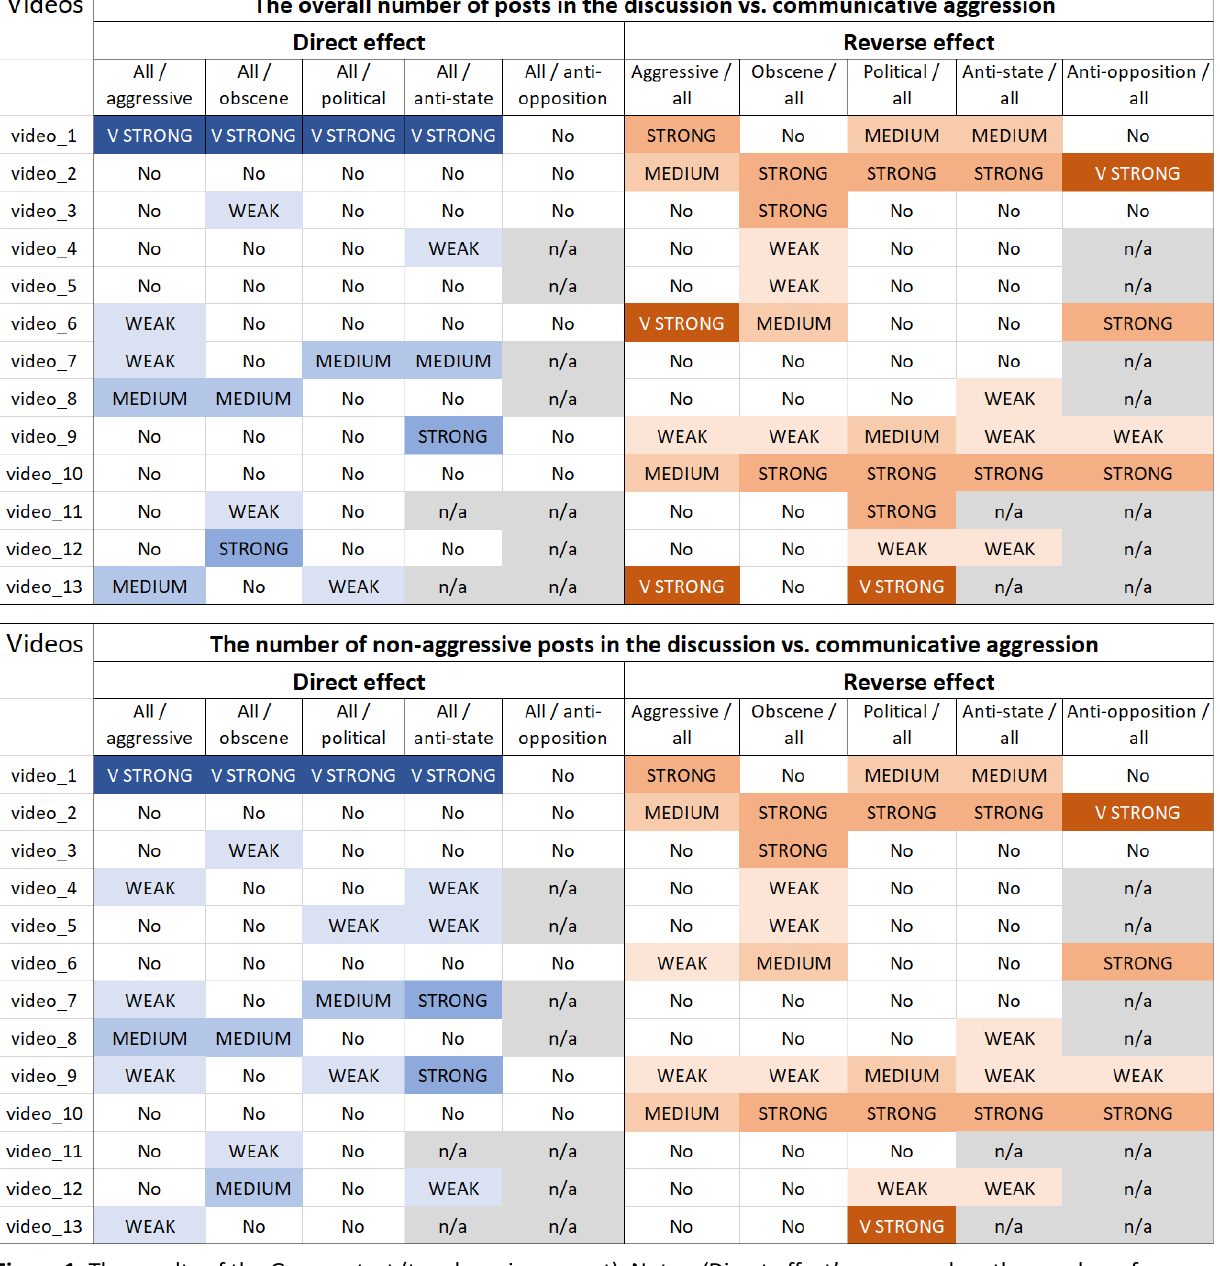
Figure 1. The results of the Granger test (two-hour increment). Notes: ‘Direct effect’ appears when the number of aggres- sive posts grows due to the overall growth of a discussion; ‘reverse effect’ appears when a discussion grows due to growth of the number of aggressive posts. 1) Blue: direct effect; orange: reverse effect; grey: data too scarce for the test. 2) Weak: F < 10, 0.01 < p ≤ 0.05; medium: p = 0.001 ≤ p ≤ 0.01; strong: F > 10, 0.0001 ≤ p < 0.001; very strong: F > 10, 1e-12 < p <